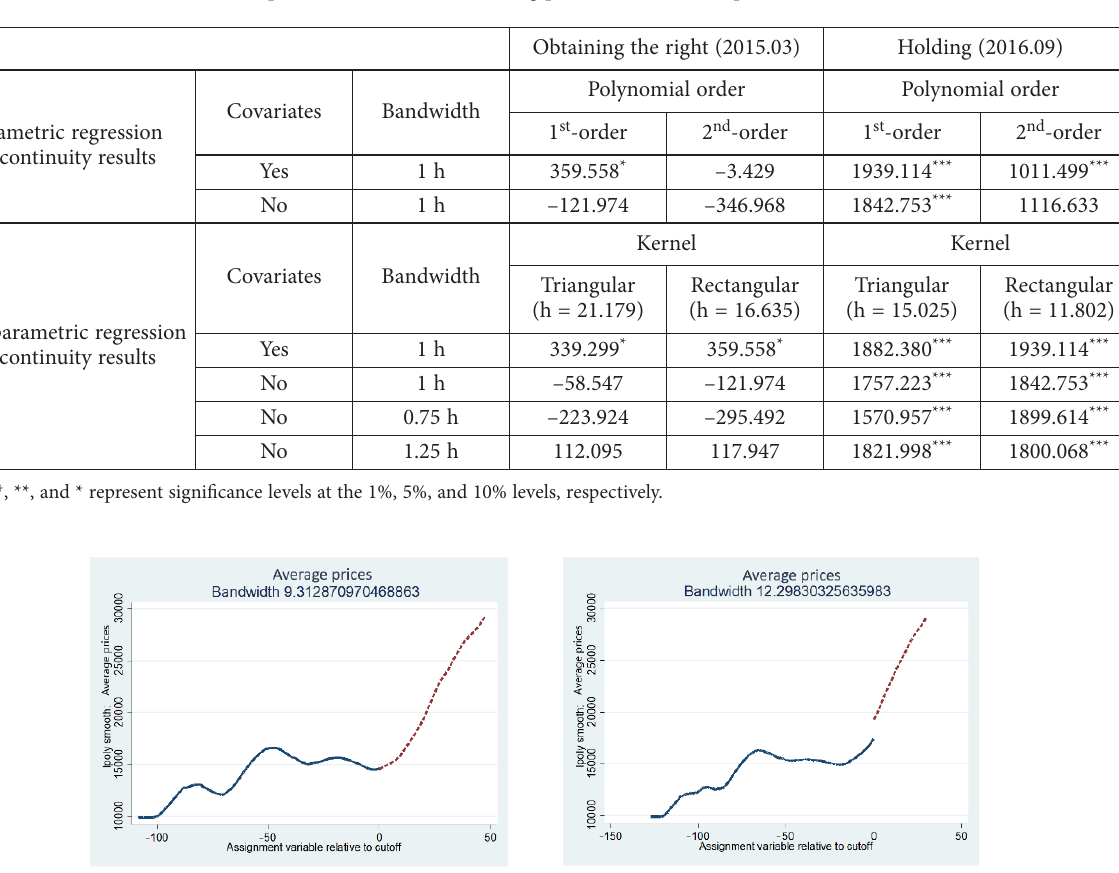
Figure 3. Impact of the G20 summit (left: winning the right, right: holding the